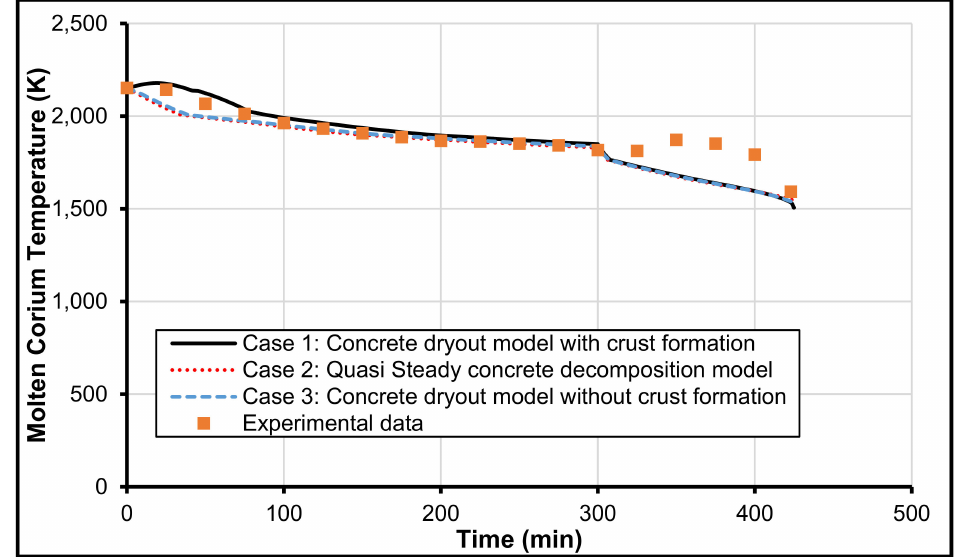
Figure 5. Comparison of CCI-2 experimental melt/corium data with the developed